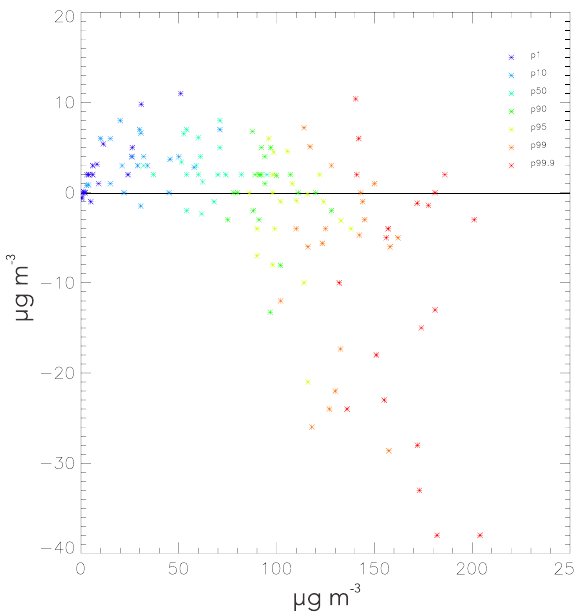
Fig. 17. The change in ozone percentiles from the 10-yr period 1990–1999 to 2000–2009 as a function of the percentile values in 2000–2009 for the 20 stations shown in the previous figure. The color codes indicate the type of